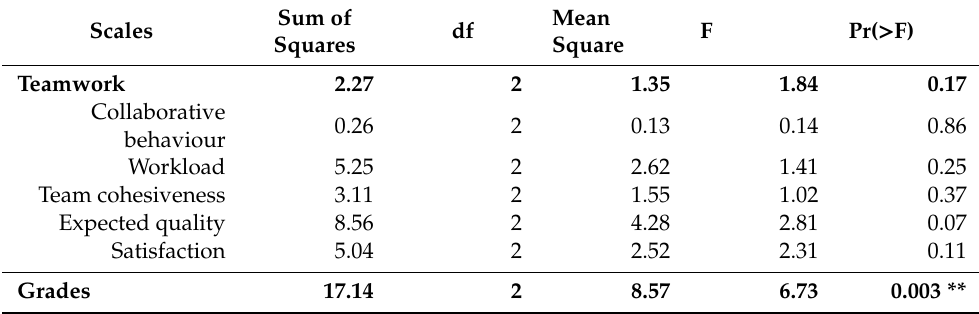
Table 3. Analysis of Variance ANOVA. Significance Pr(>F) > 0.1.